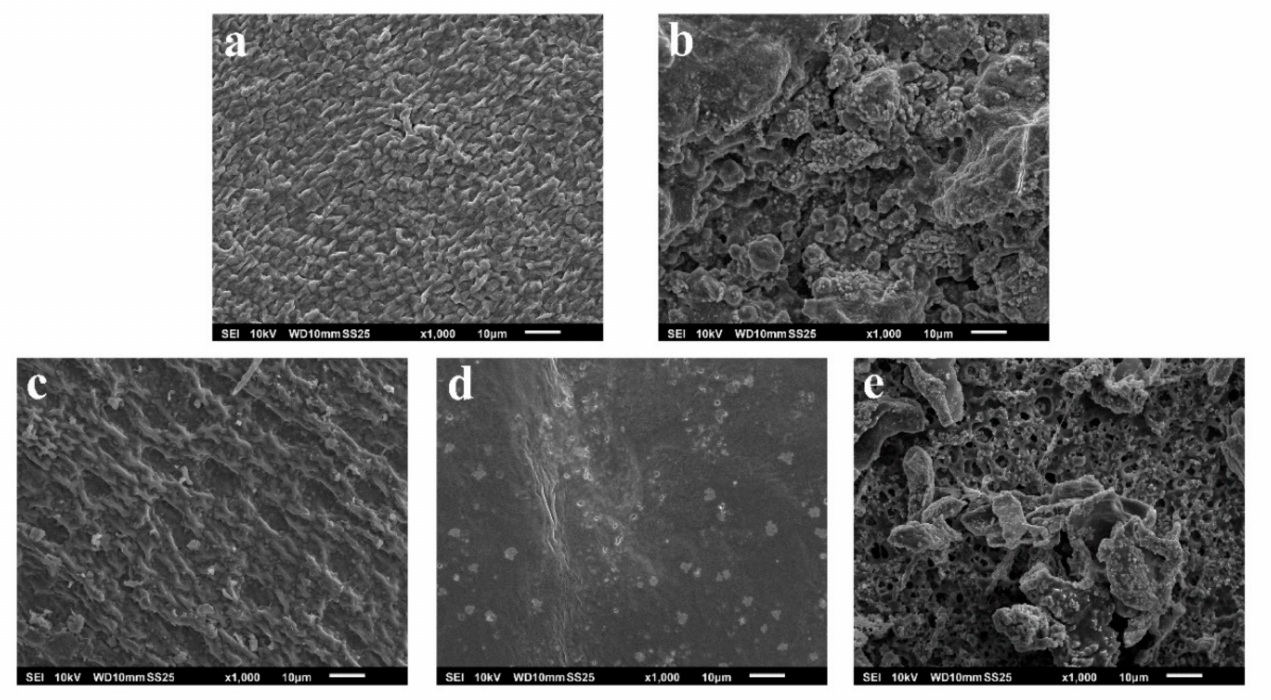
Figure 4. SEM images of Up ( a ), Up-MAE ( b ), Sm ( c ), Sm-PHW ( d ), and Sm-US ( e )